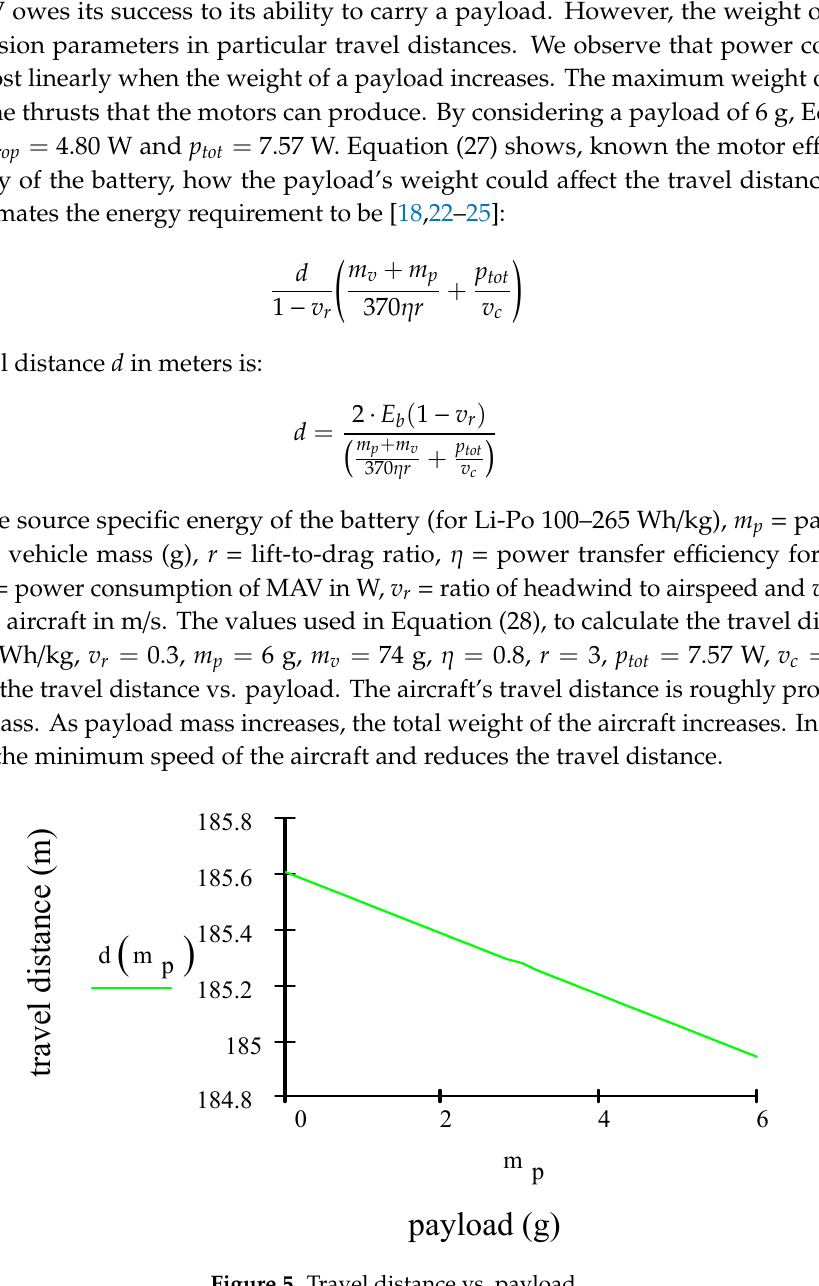
Figure 6. Travel distance as a function of motor efficiency and cruising velocity. 2.2.5. Impact of Wind Wind condition is a major environmental factor that affects the power consumption of a MAV. We are only considering the flight of a MAV in headwind conditions. In this scenario, the motors are forced to generate more thrust to maintain a horizontal condition and thrust requires power. The drone was set to fly with a wind speed of 7 m/s. Equation (25) will be re ‐ written considering the power needed to overcome